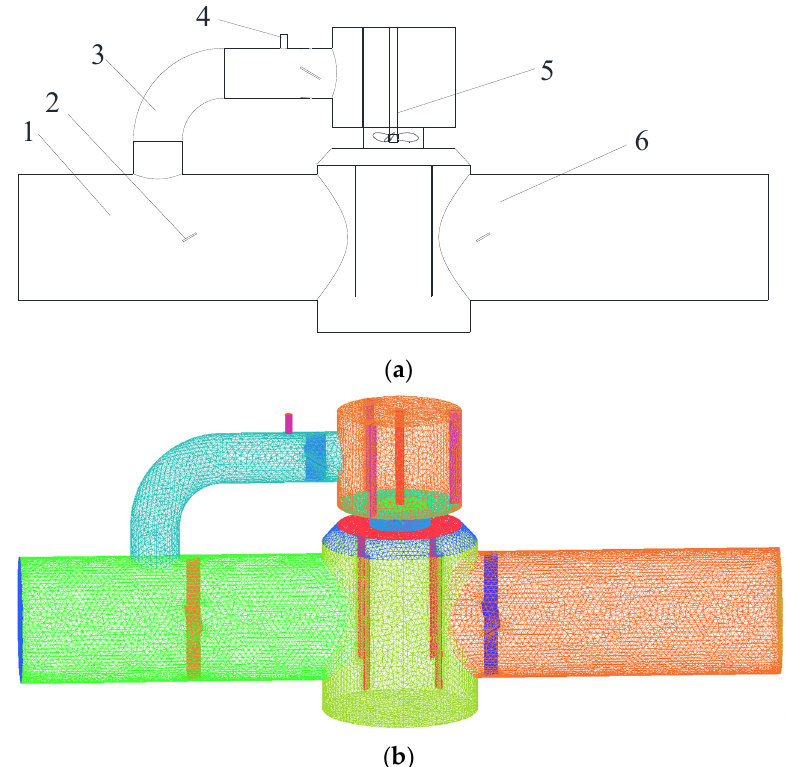
Figure 1. Schematic diagram of the mixer and grid division: ( a ) schematic diagram of mixer; (1) main pipe; (2) deflector; (3) branch pipe; (4) dosing pipe; (5) frequency conversion mixing device; (6) outlet pipe); ( b ) schematic diagram of the grid division.